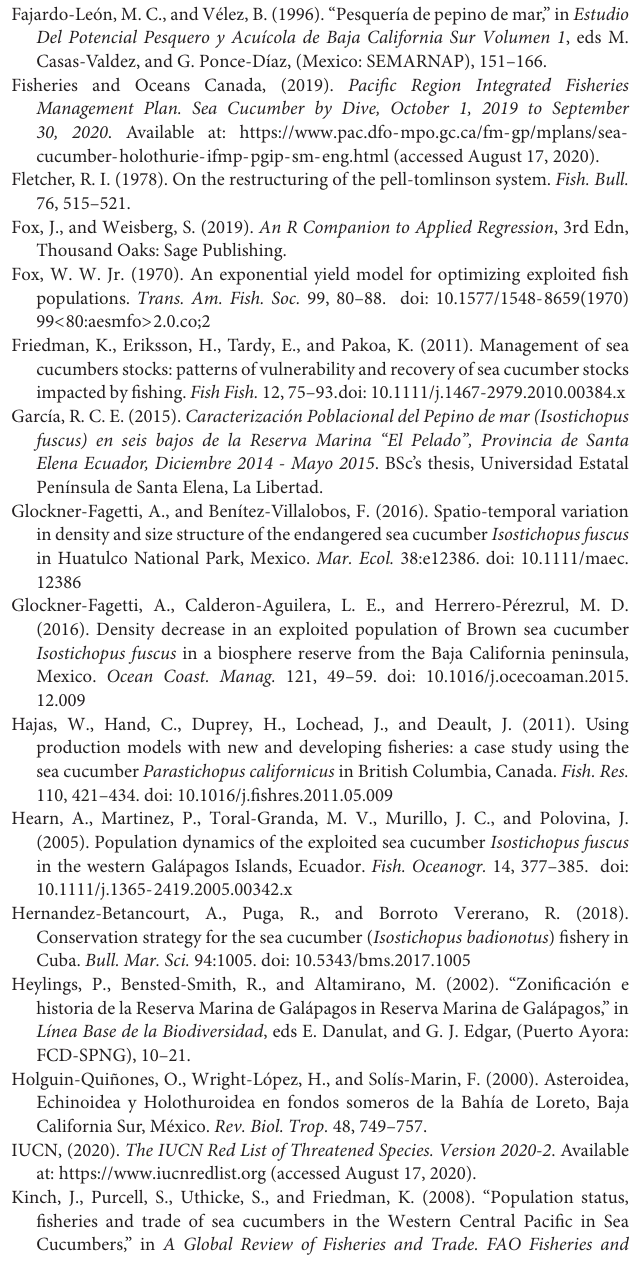
Supplementary Table 1 | Months, depth, and number of plot settled in the annual density monitoring programs, catches recorded, abundances calculated and CPUE standardized of I. fuscus in the GMR from 2000 to 2019. Supplementary Table 2 | Kruskal-Wallis tests and p -values of the pairwise comparisons using Wilcoxon rank sum test with Holm method for densities between bioregions and between islands within Central-southeastern bioregion of the population monitoring programs of I. fuscus in the Galápagos Marine Reserve. Supplementary Table 3 | Density medians (sea cucumbers/100 m 2 ) of I. fuscus for year and monitoring zone and area (km 2 ) calculated for each monitoring zone. ∗ Average of previous year’s density value with the following year’s density.